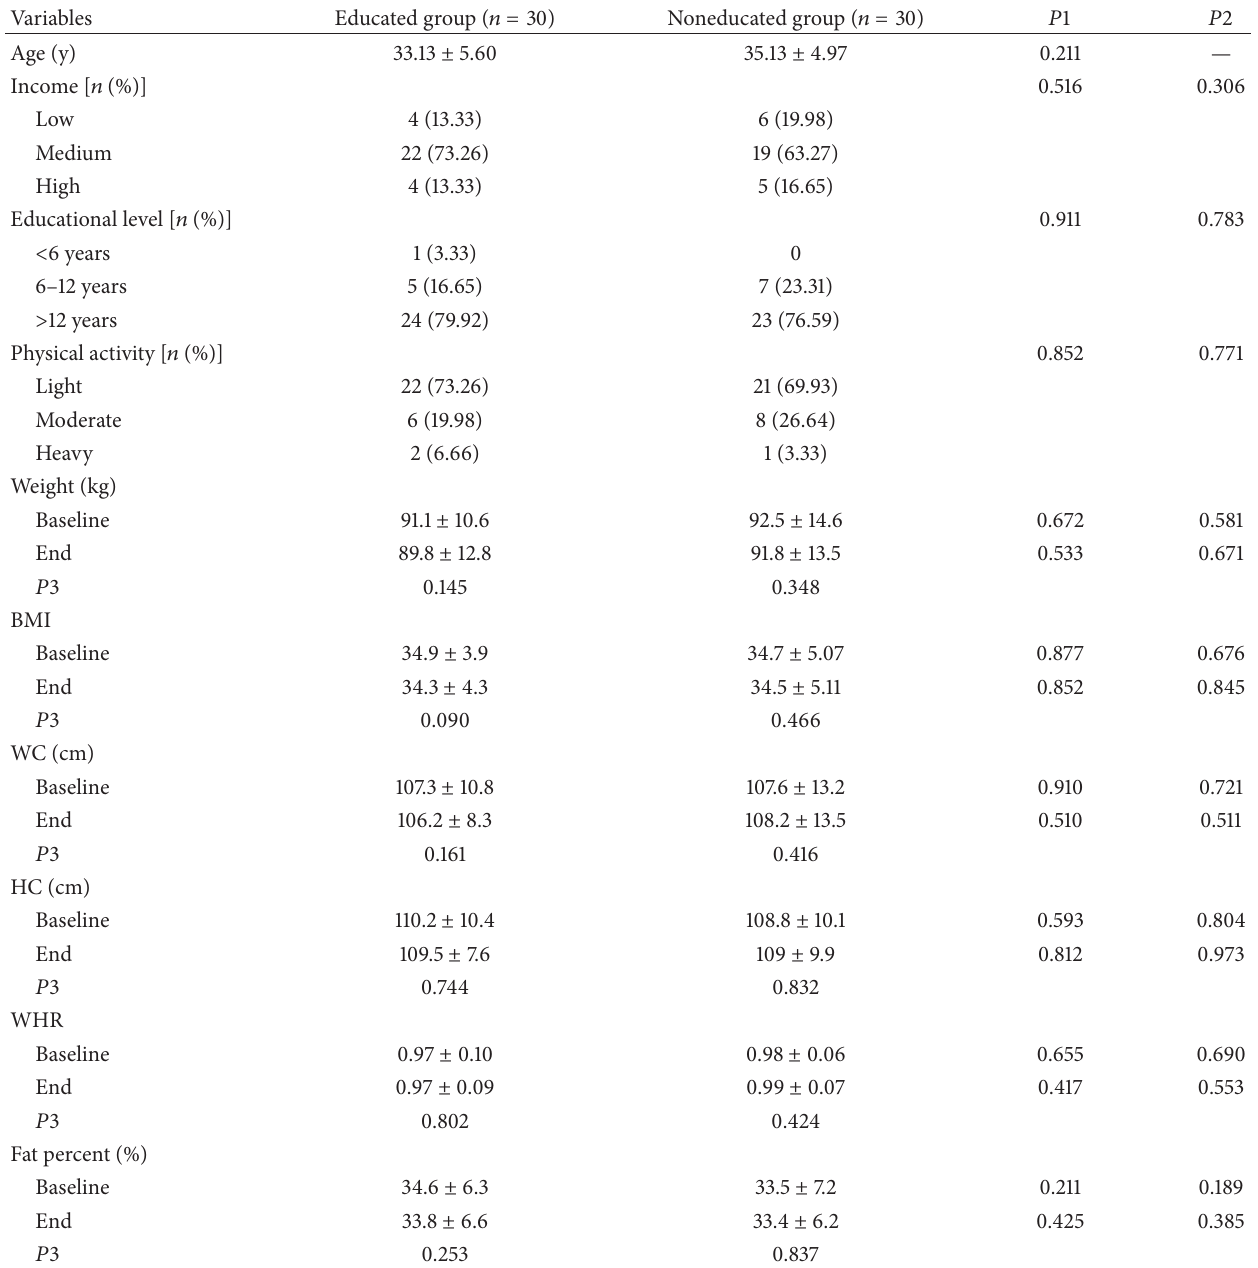
Table 1: Sociodemographic and anthropometric characteristics of the study groups at the baseline and end of